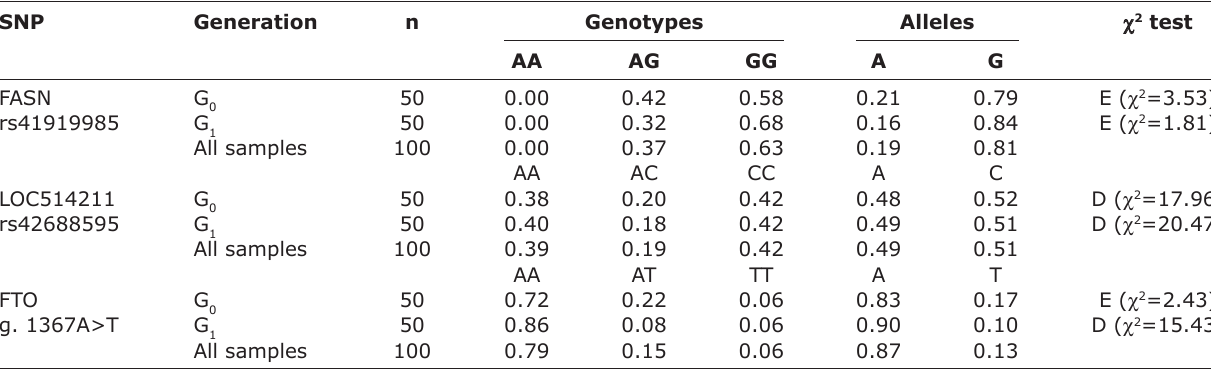
FASN=Fatty acid synthase, FTO=Fat mass and obesity-associated, n=The number of samples, G G